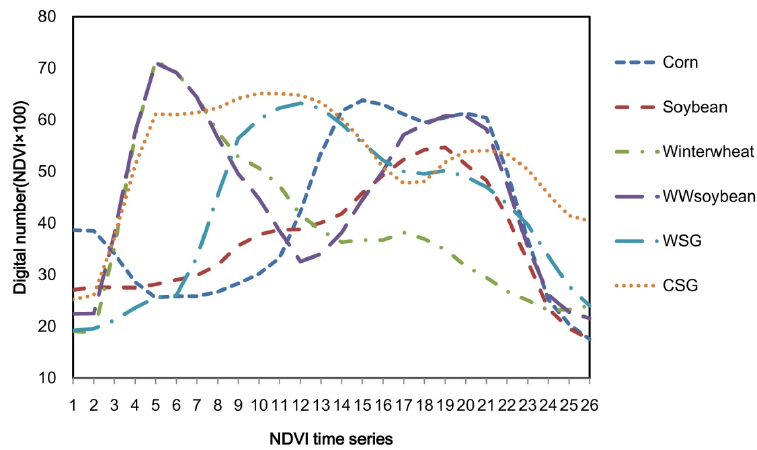
Figure 3. The average NDVI time series of six crops in the study area.